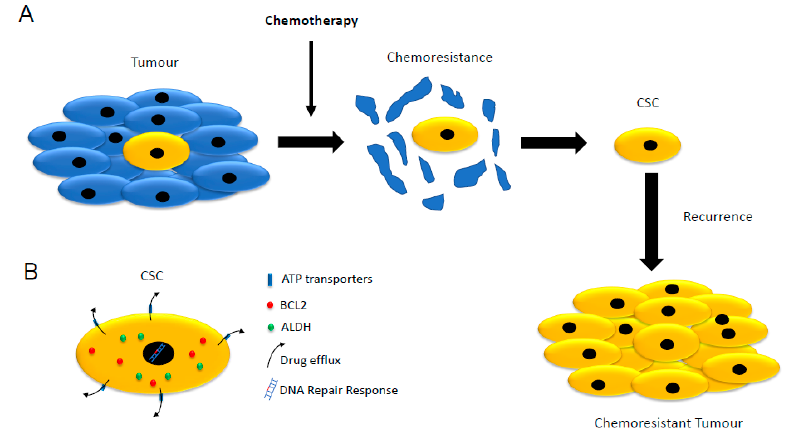
Figure 1. Schematic representation of cancer stem cells (CSCs) and their role in chemoresistance. ( A ) Chemotherapy destroys most of the highly proliferative cancer cells. CSCs are less a ff ected by chemotherapy and can re-initiate cancer and promote cancer progression. ( B ) CSCs possess several mechanisms that counteract the e ff ect of chemotherapeutic compounds such as the ATP family of